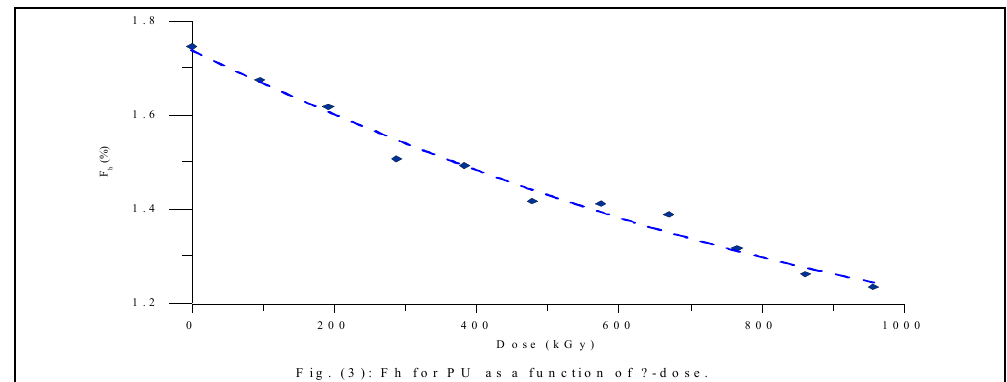
Fig. 3: Fh for PU as a function of γ